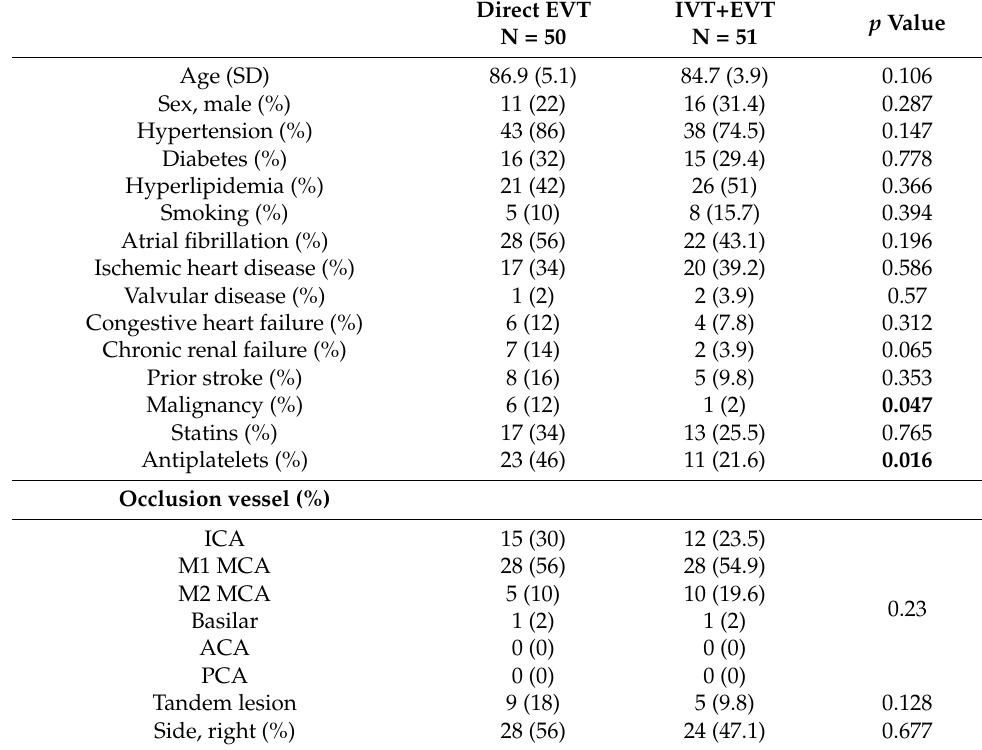
Table 2. Characteristics of patients aged ≥ 80 years in the direct EVT and IVT+EVT